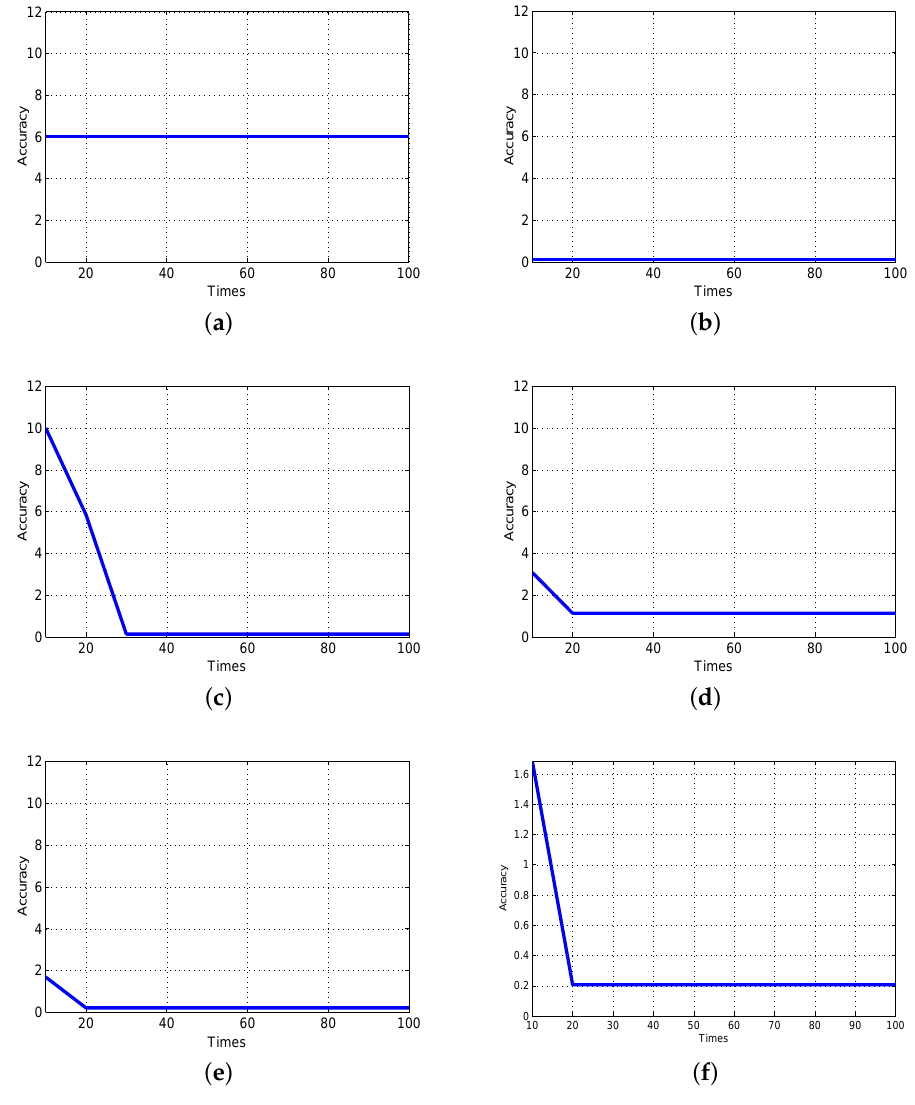
Figure 6. Optimization accuracy curve based on adaptive PSO algorithm. ( a ) Optimization accuracy with 5 particles; ( b ) Optimization accuracy with 15 particles; ( c ) Optimization accuracy with 25 particles; ( d ) Optimization accuracy with 25 particles; ( e ) Optimization accuracy with 35 particles; ( f ) Optimization accuracy with 35